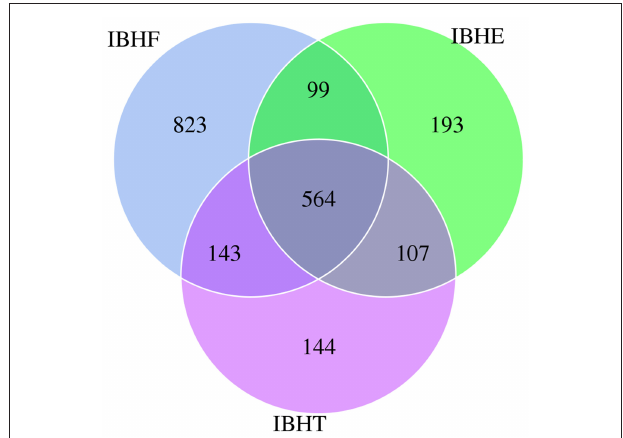
FIGURE 1 | Venn diagram of operational taxonomic units (OTUs) in different growth periods. Note that the overlapping parts show the OTUs shared by three groups, and the numbers on both sides are the unique OTUs owned by each group. IBHE, IBHT, and IBHF refer to “ISA Brown Hens-8 weeks,” “ISA Brown Hens-20 weeks,” and “ISA Brown Hens-50 weeks,”